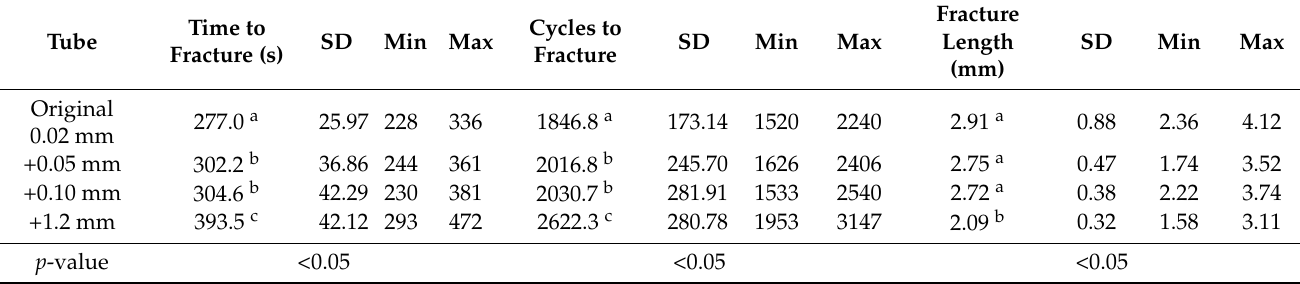
Table 1. Time and cycles to fracture and fracture length of instruments with standard deviation, minimum, and maximum values ( p < 0.05). Values sharing the same superscript letters are not statistically different at a 0.05-level. Time Tube